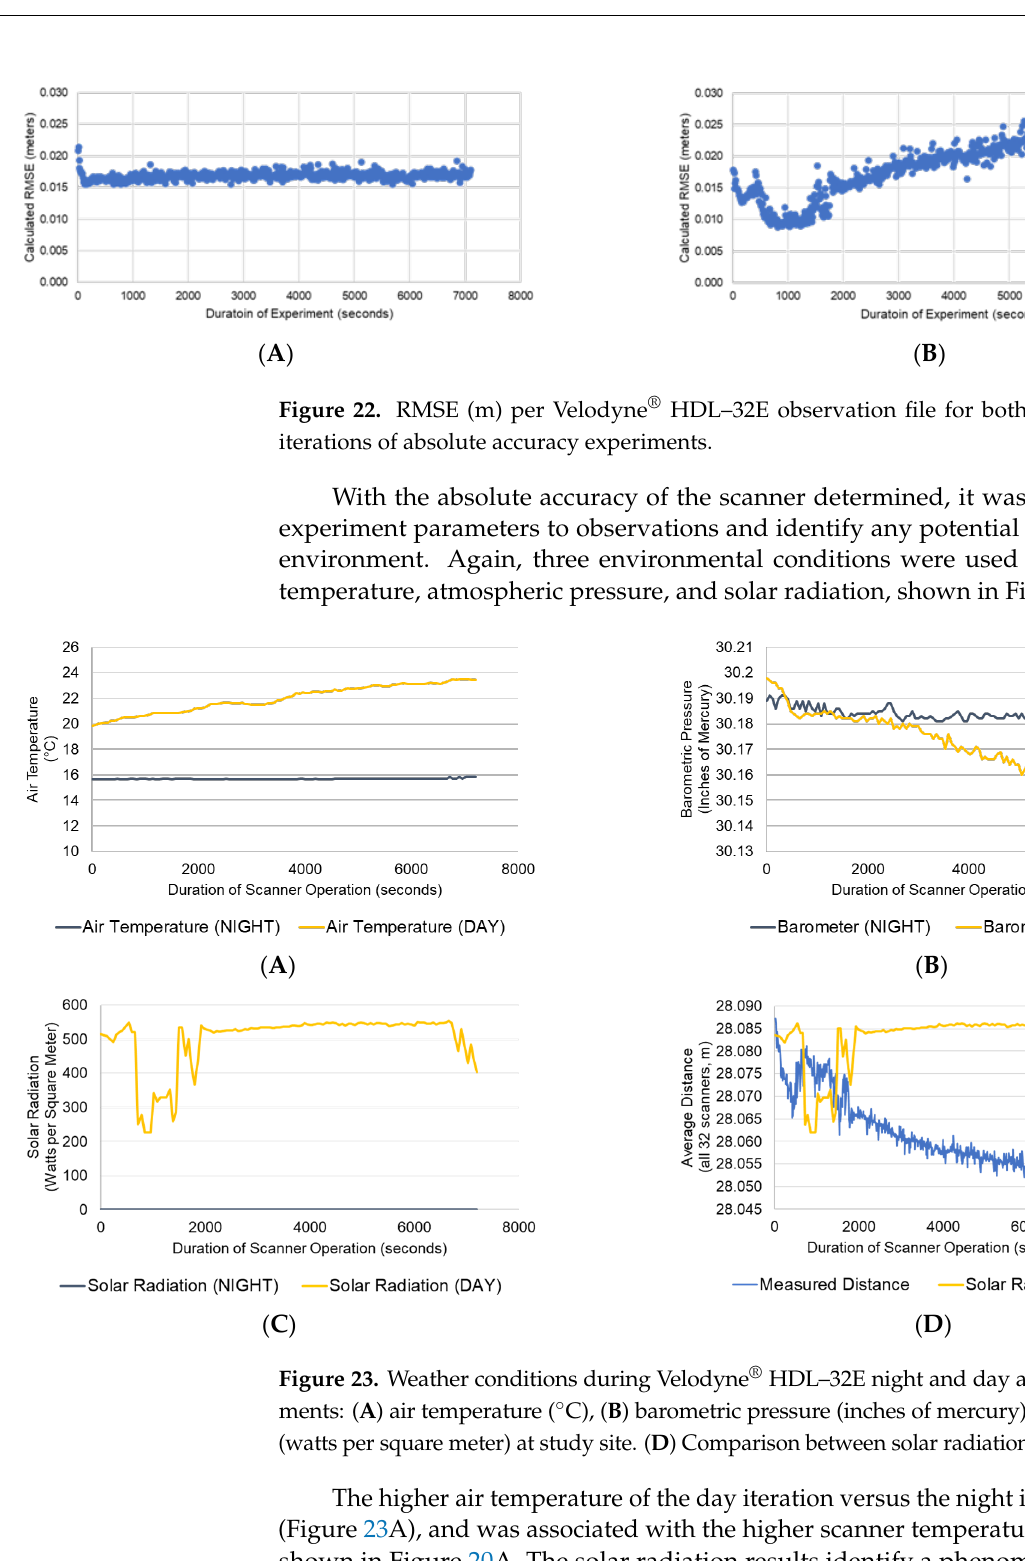
( B ) Figure 24. Linear relationship between Velodyne ® HDL–32E average distance measurements and internal temperature for both night and day experiments, ( A ) with and ( B ) without the interference caused by solar radiation, with average truth values plotted for each experiment. 3.2. Livox ® Mid–40 Following the same series of indoor test protocols as the Velodyne ® HDL–32E, the Livox ® Mid–40 was subjected to a series of indoor experiments to establish baseline of scanner behavior under controlled conditions. Because the Mid–40’s field of view is lim- ited to ±19.2° in all directions from the normal of the scanner face, no restriction of scan angle was applied and the entire field of view was included in the analysis.